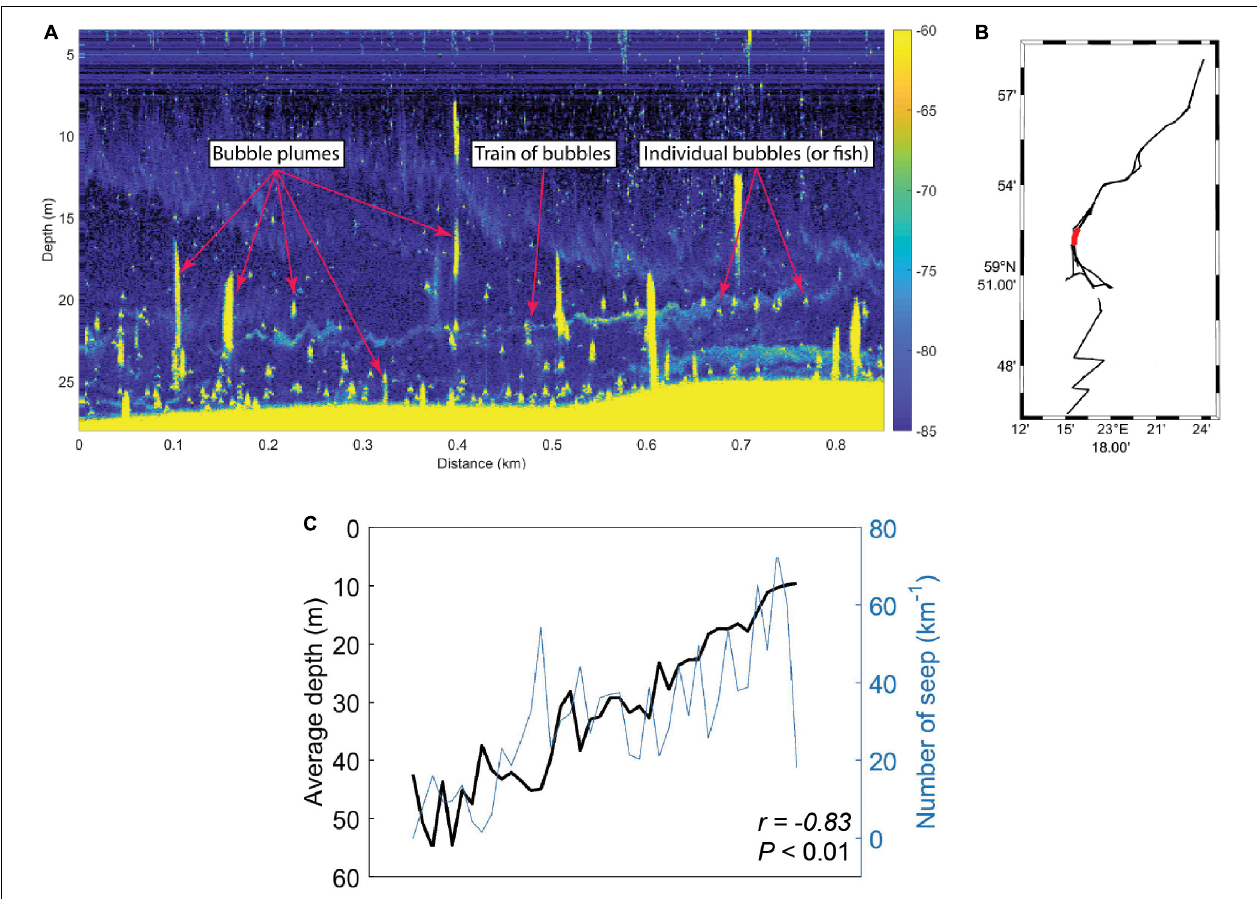
FIGURE 5 | Onboard the research vessel acoustic data (EK80 wide band transceiver) was collected from the southern, central, and northern Storfjärden bay. (A) Example of echogram with seeps from the seafloor and within the water column. The right-side y -axis shows target strength (dB) as a function of horizontal distance ( x -axis) and water depth (left-side y -axis). (B) Map of the Storfjärden bay showing the data track from all the acoustic data that were collected (black) and the track shown in the echogram in A (red). (C) Water depth (black line, y -axis increasing with lower water depth) compared to the number of CH 4 seeps observed (blue line, y -axis increasing with more CH 4 seeps). The r and P -value shows the results from the Pearson